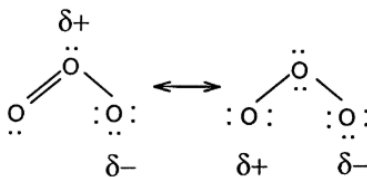
Figure 15. The chemical structure of ozone. Reproduced from Ref. [91]. Copyright 2003 Elsevier.